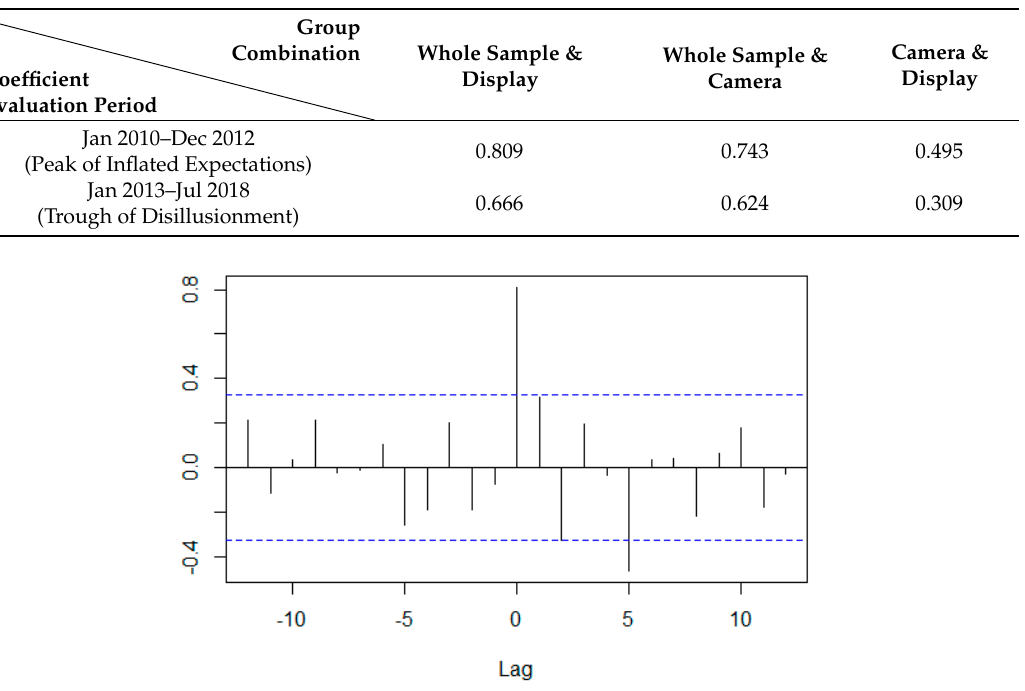
Figure 23. Cross-correlation coefficient between monthly rate of return of the whole sample group and monthly rate of return of the display group for Jan 2010–Dec 2012.